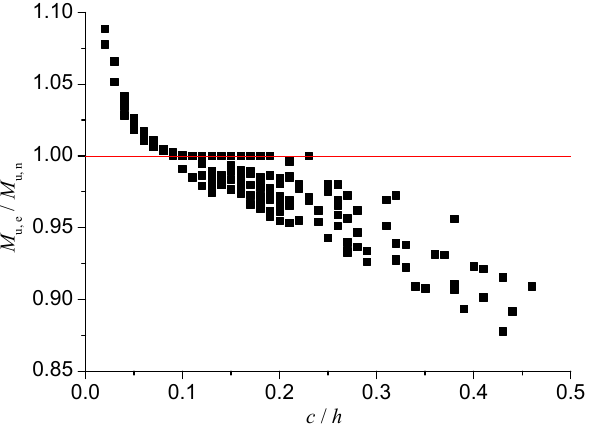
Figure 9. Comparisons of calculated results from simplified plastic method and nonlinear method.